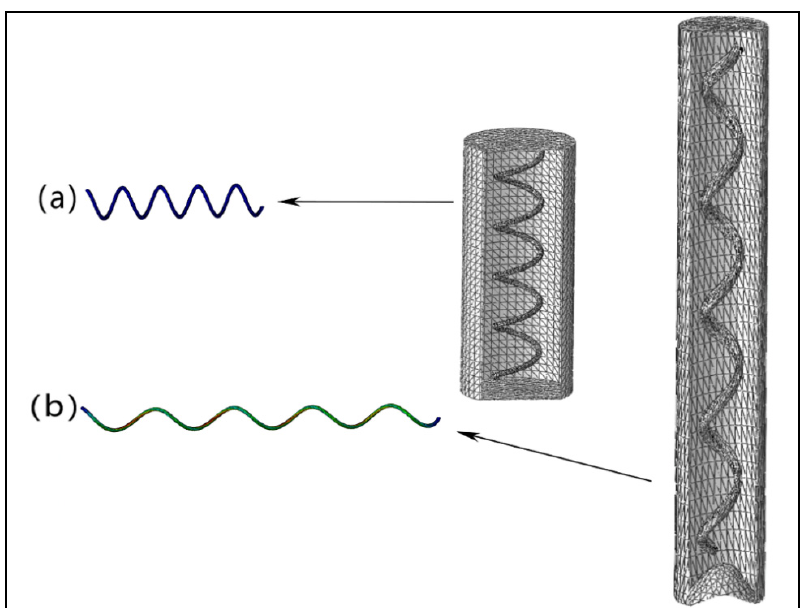
Figure 11. Comparison of spiral carbon fiber before and after drawing: ( a ) before drawing; ( b ) after drawing.